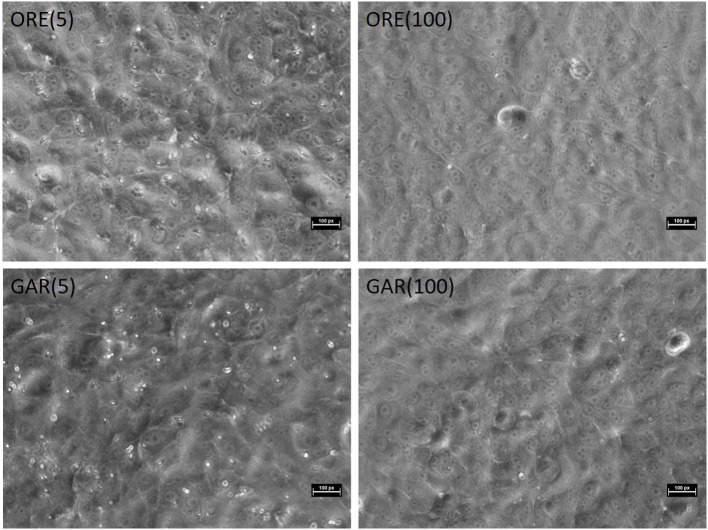
MDBK monolayers infected with pre-treated sporozoites at 24 HPI. Pre-treatment with the lowest doses of essential oils showed little reduction in infection; almost no intracellular sporozoites were found when the highest doses were used. MDBK morphology was not affected by the treatment. ORE, oregano; GAR, garlic; (5), 5 μg/ml; (100), 100 μg/ml. Bars ~30 μm.